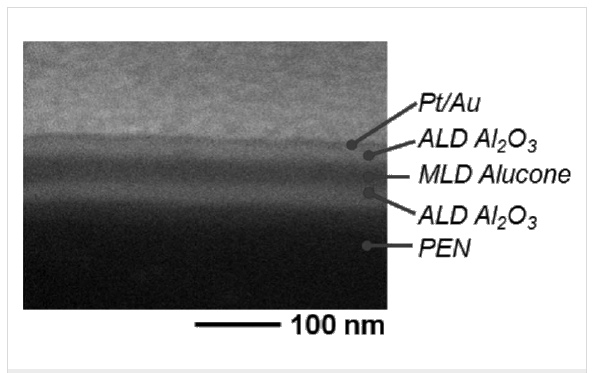
Figure 12: A nanolaminate coating consisting of Al 2 O 3 and TMA+EG alucone layers with targeted thicknesses of 25 and 15 nm, respective- ly, on a polyethylene naphtalate (PEN) substrate (reprinted with permission from [81], Copyright (2009) American Institute of